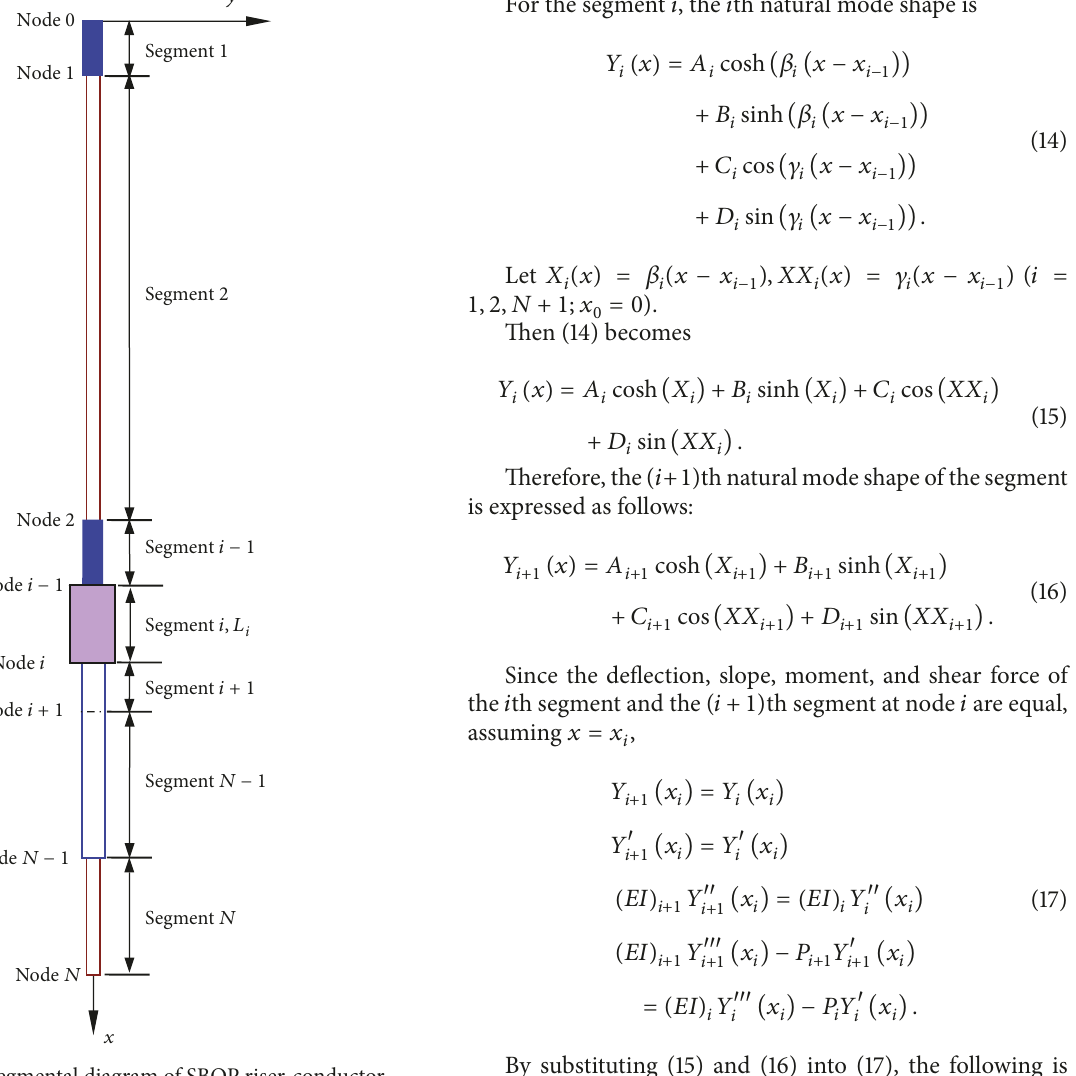
Figure 2: The segmental diagram of SBOP